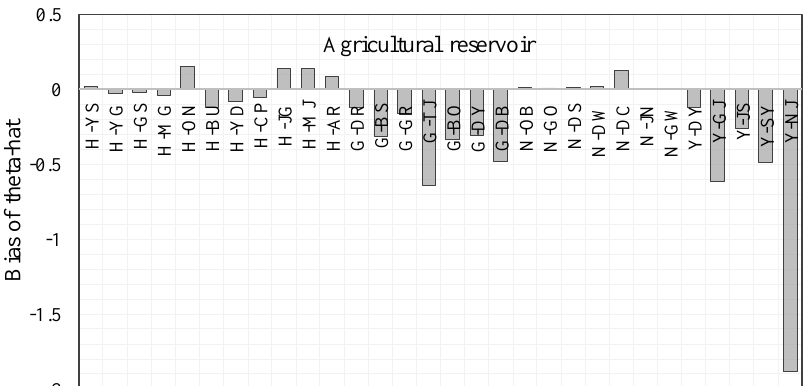
Figure 8. Bias of θ̂ for a 24-h duration and a 200-y return period for 2040s under the RCP4.5 scenario for 30 agricultural reservoir watersheds. The estimator ( θ̂ ) is the mean. Refer to Table 1 for reservoir names.